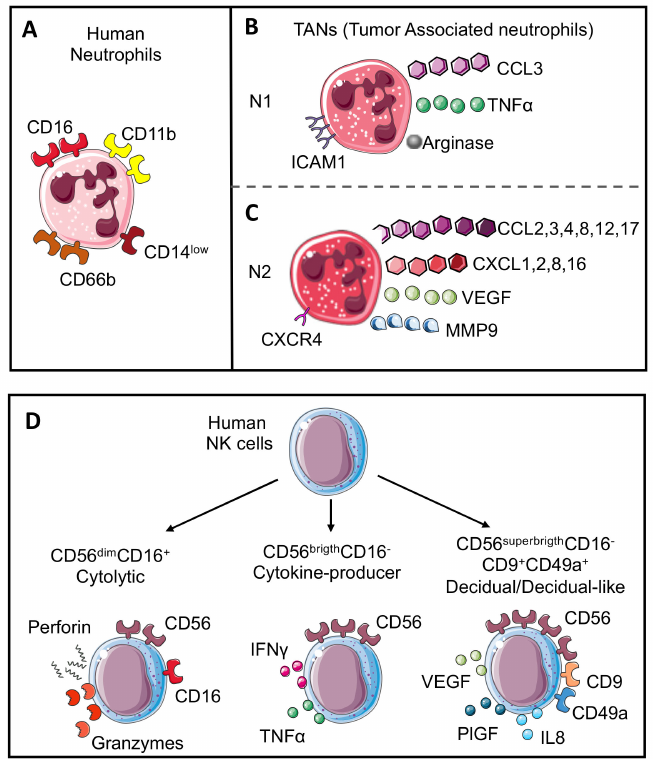
Figure 1. Neutrophil and NK cell subsets . Human neutrophils ( A ) are characterized by CD11b, CD66b, CD14, and CD16 expression. Mimicking the M1 or M2-like macrophage polarization, neu- trophils in the tumor microenvironment are also characterized by the capability to acquire two opposite phenotypes. N1 neutrophils ( B ) show anti-tumoral activities and are characterized by the expression of chemokine (C-C motif) ligand 3 (CCL3), tumor necrosis factor α (TNF α ), arginase, and intercellular adhesion molecule 1 (ICAM1); in contrast, N2 neutrophils ( C ) work as tumor-promoters and express CC and CXC chemokines (CCL2, 3, 4, 8, 12 and 17 and CXCL1, 2, 8, and 16), vascular endothelial growth factor (VEGF), matrix metalloprotease 9 (MMP9), and CXCR4 receptor. Human NK cell subsets ( D ) are characterized by CD56 expression. Cytolytic NK cells express CD56 and CD16 (CD56 dim CD16 + ) and can release perforin and granzyme; cytokine producer NK cells lose CD16 ex- pression and increase CD56 expression (CD56 brigth CD16 − ) with the production of cytokines including TNF α and interferon γ (IFN γ ); the last subset is named decidual cells (dNKs) that displayed higher expression of CD56 with CD9 and CD49a markers (CD56 superbrigth CD16 − CD9 + CD49a + ) and support angiogenesis through the release of VEGF, placental growth factor (PlGF), and interleukin 6 (IL6). A similar subset named decidual-like NK cells is also found in the tumor microenvironment